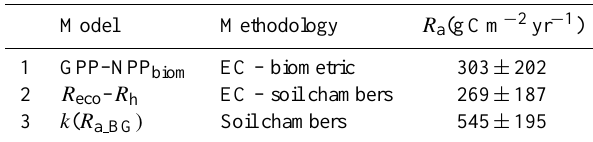
Table 6. Computed values of R a ( ± se) obtained from the three methodologies discussed in Sect. 2.4 (Eqs. 8, 9 and 10). The co- efficient k obtained from the ratio between total and BG nitrogen content in the standing biomass was 2.92 ± 0.27. The average R a value (372 ± 195gCm − 2 yr − 1 ) is reported in Fig. 7.